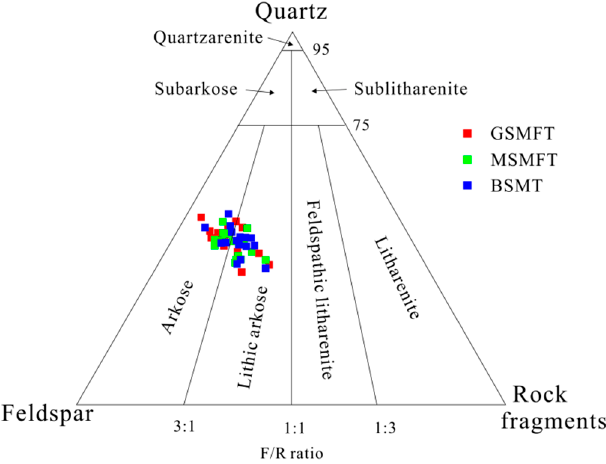
Figure 7. Particle composition of three pore-throat structure types plotted on the classification triangle.